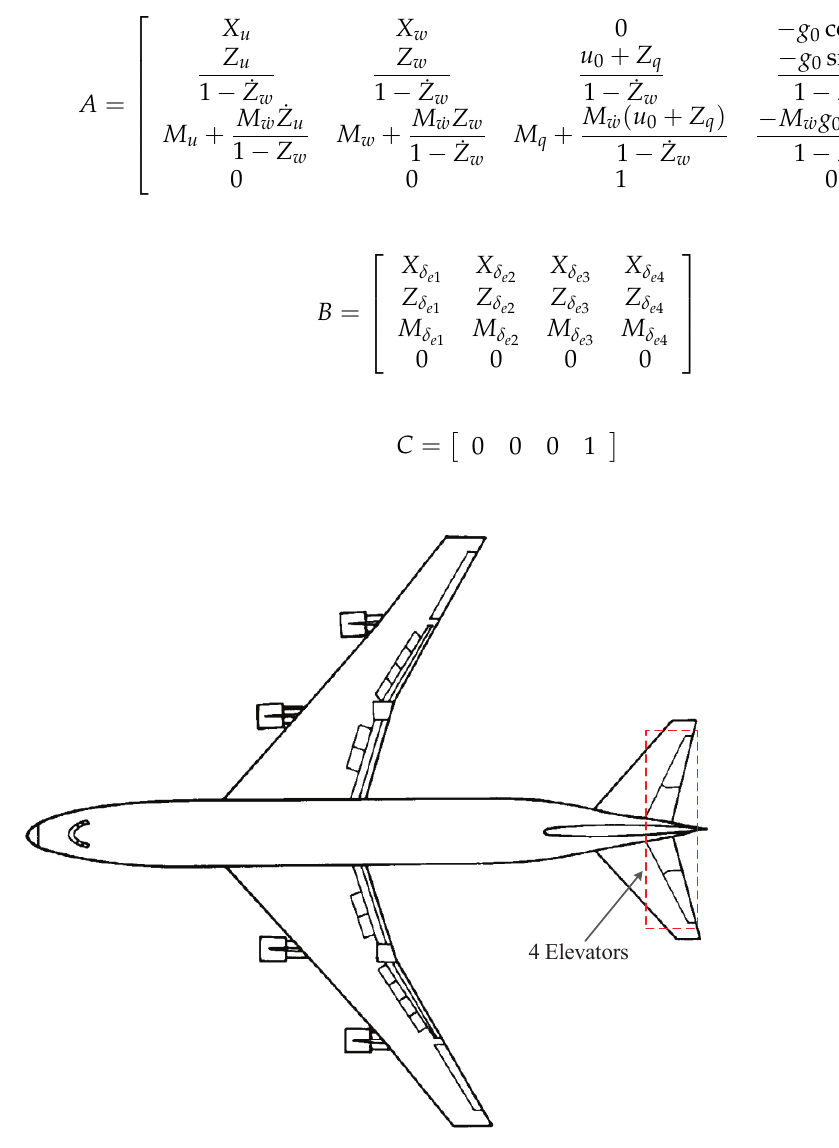
Figure A1. The schematic for Boeing 747.